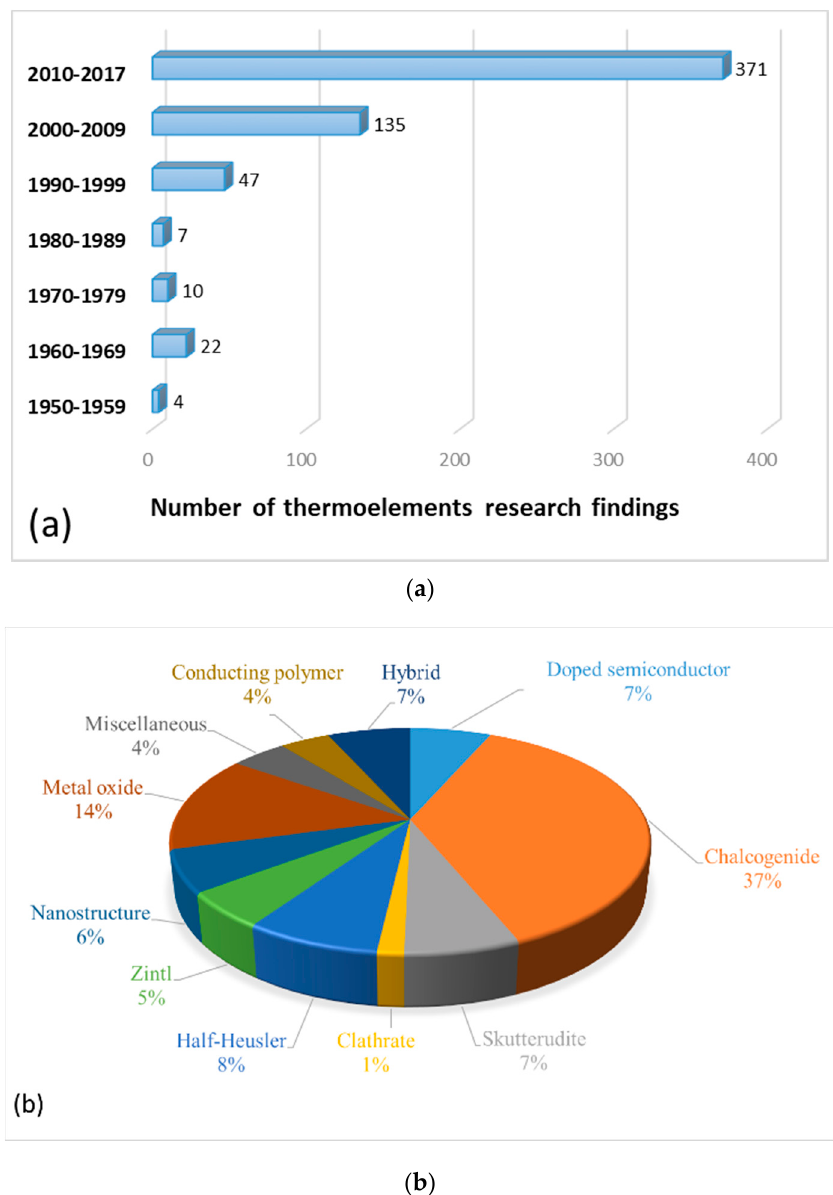
Figure 4. ( a ) State of the art thermoelement research findings by year; ( b ) Development rate in the thermoelements research from 1950 to 2017. Data from [94].